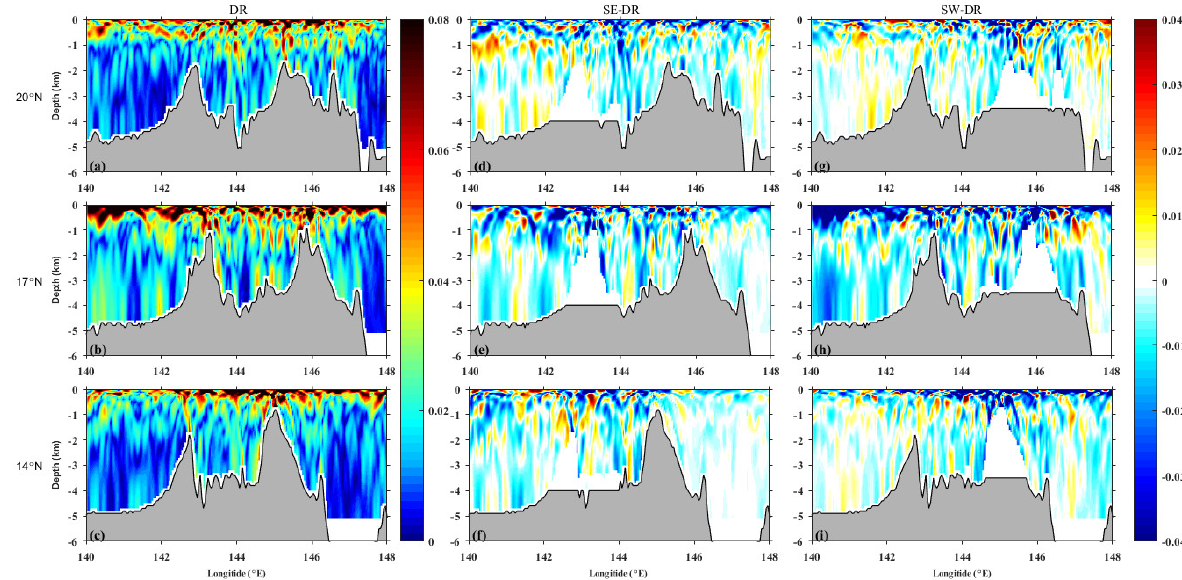
Figure 6. The amplitude of M 2 internal tidal zonal velocity (m/s) along 20° N ( a ), 17° N ( b ), and 14° N ( c ). Scheme 20° N ( d ), 17° N ( e ), and 14° N ( f ) sections. The result of subtracting the amplitude (m/s) of the DR case from the SW case (SW-DR) along 20 ◦ N ( g ), 17 ◦ N ( h ), and 14 ◦ N ( i ) sections. Gray shaded areas represent topography along the sections.